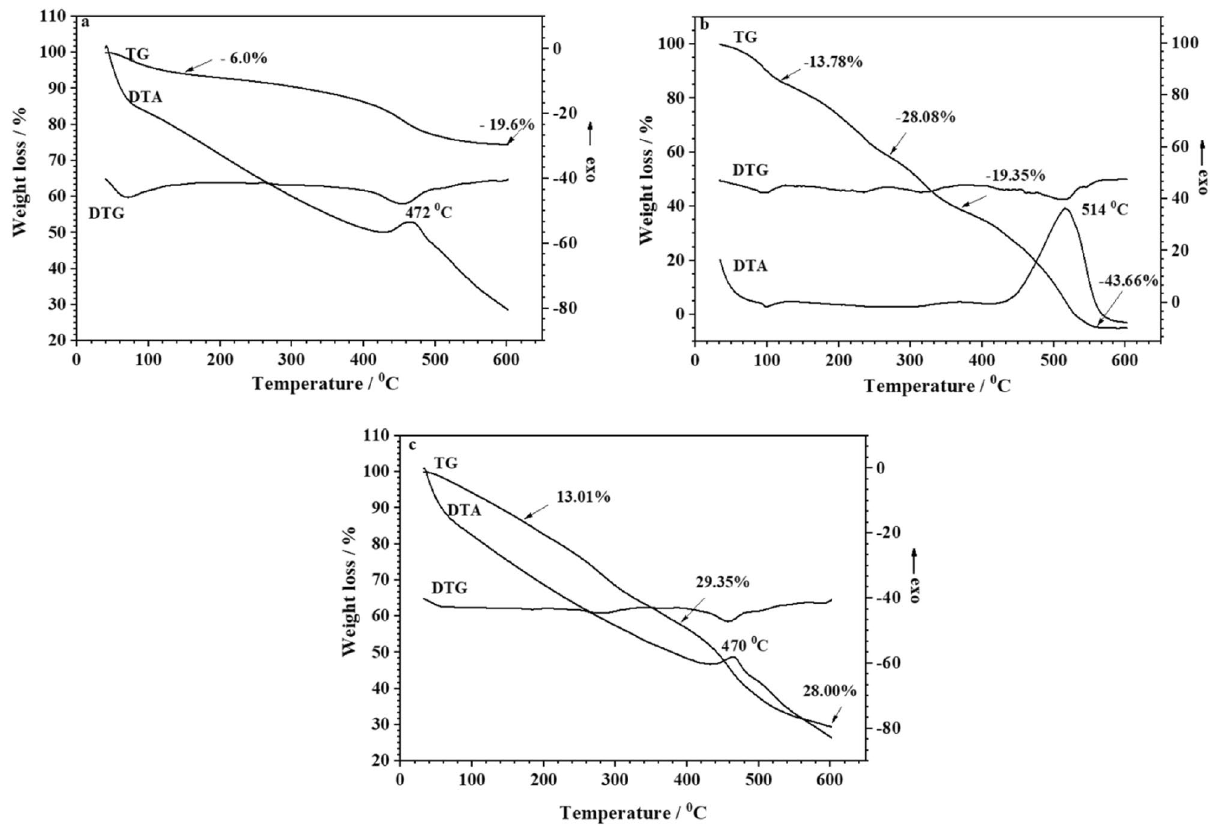
Figure 3. TG/DTG/DTA diagrams of samples: ( a ) GIC, ( b ) BPE, ( c ) GIC-BPE, before immersion in